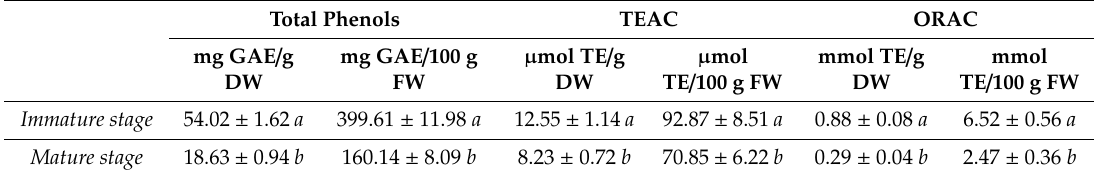
Table 3. Total phenols and antioxidant capacity, expressed as Oxygen Radical Absorbance Capacity (ORAC) and Trolox equivalent antioxidant capacity (TEAC), of Opuntia ficus-indica extracts, from immature and mature cladodes. Total phenols are expressed as gallic acid equivalents (GAE), TEAC and ORAC assays are expressed as Trolox Equivalent (TE). Mean values ( n = 11) ± standard deviation (SD) are expressed on a dry weight (DW) or fresh weight (FW) basis. The same letters (a,b) in the same column indicate that mean values are not significantly di ff erent ( p <